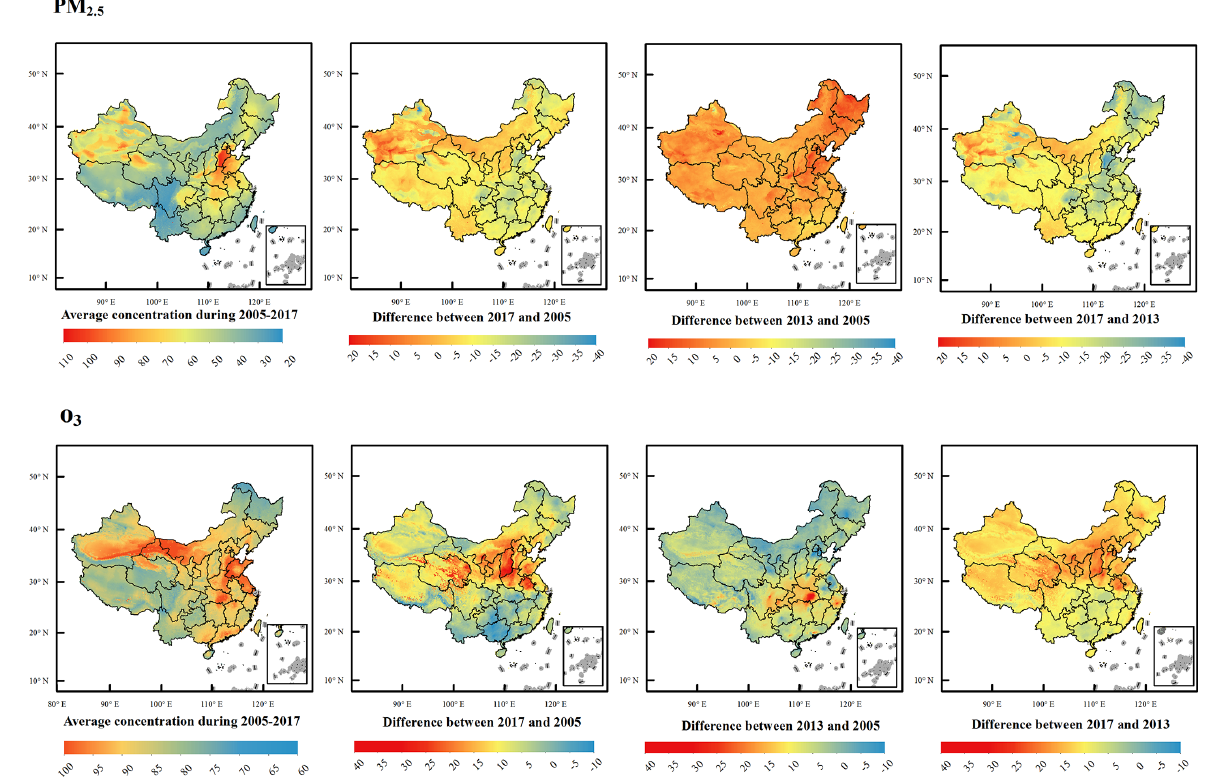
Figure 6. Estimated annual mean and difference of PM 2 . 5 and O 3 -8hmax concentration in China during 2005 to 2017. The first row shows maps of PM 2 . 5 -related indicators, and the second row shows maps of O 3 -8hmax related indicators. From left to right are the average concentrations during 2005–2017, the difference between 2017 and 2005, the difference between 2013 and 2005, and the difference between 2017 and